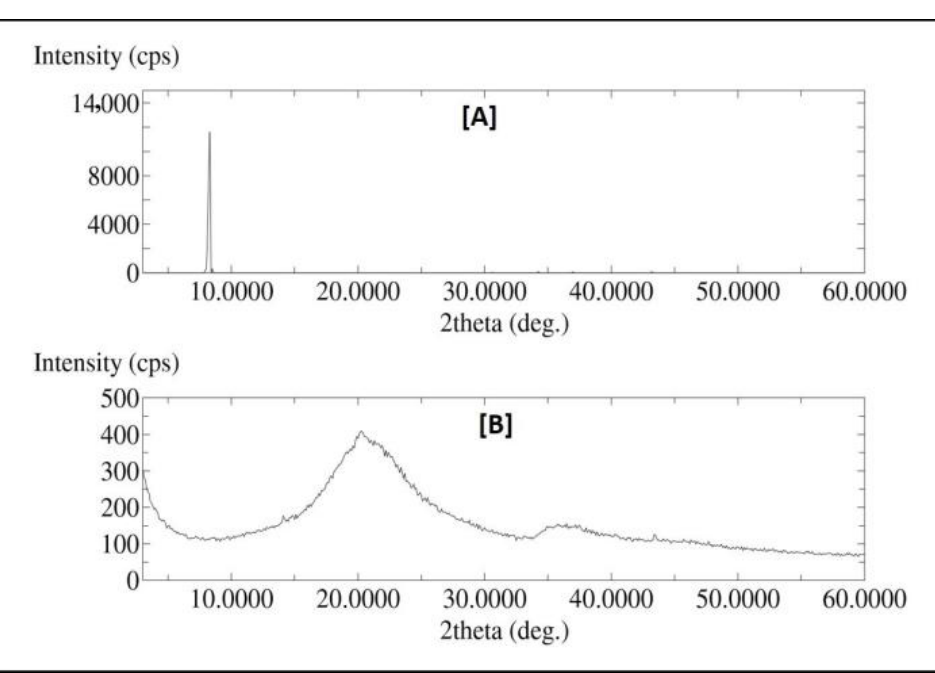
Figure 3. XRD of ( A ) pure thymoquinone and ( B ) thymoquinone-loaded liposomal formulation